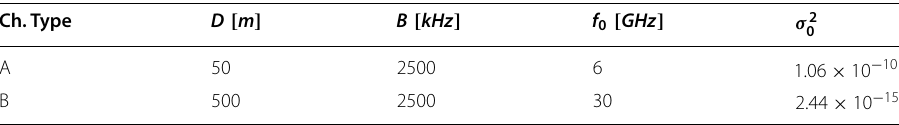
Table 5 Channel parameters Ch. Type